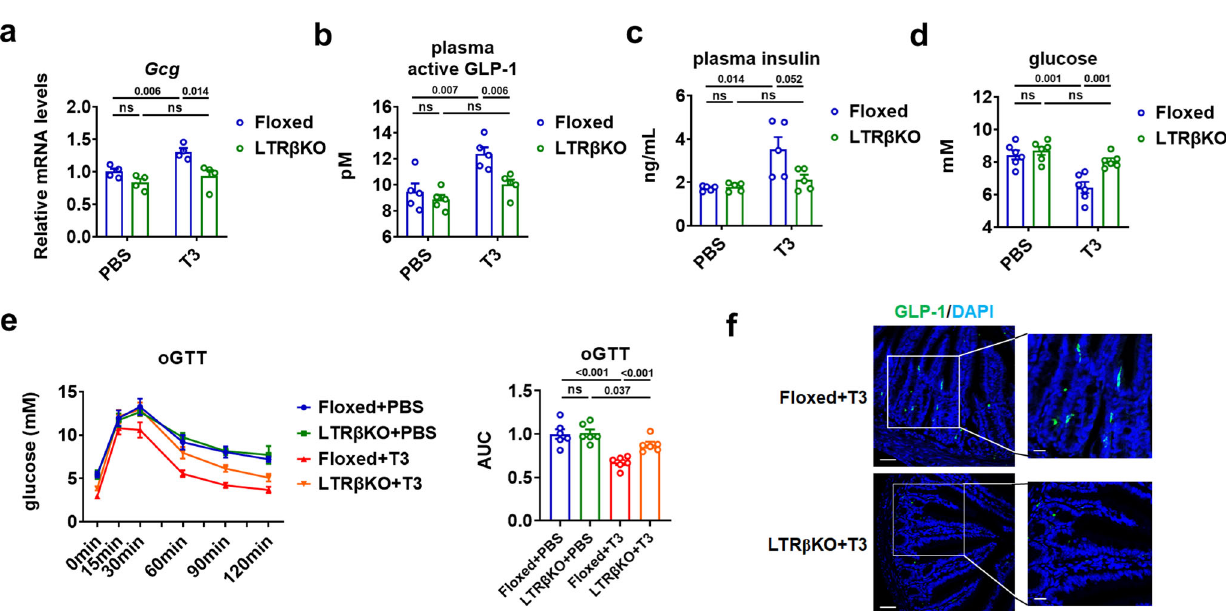
Fig. 2 | The hepatic TR β is required for the regulatory effect of T3 on glucose metabolism. a Relative Gcg mRNA levels in the ileum of Floxed and LTR β KO mice treated with PBS or T3 for 5 days as indicated ( n =4). b – d Plasma active GLP-1 ( b , n =5), plasma insulin ( c , n =5), and blood glucose levels ( d , n =6) in Floxedand LTR β KOmicetreatedwithPBSorT3for5daysasindicated. e oGTTforFloxedand